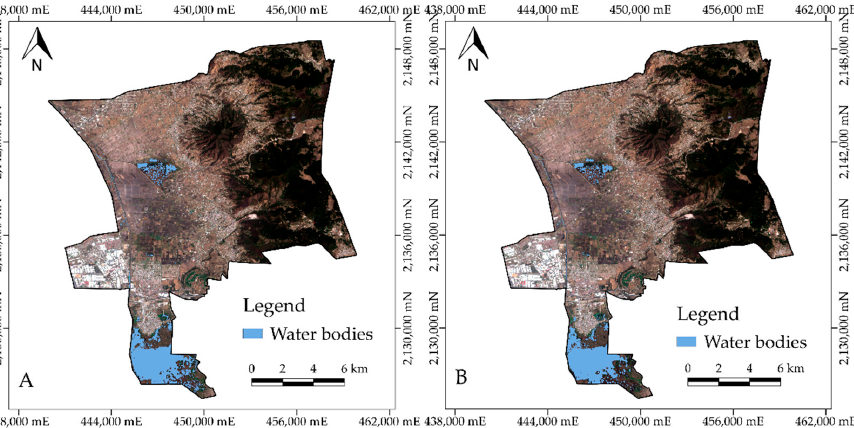
Figure 6. Extent of water bodies obtained using the GB ( A ) and RF ( B ) algorithms with the best combination (combination 15) for the dry season.